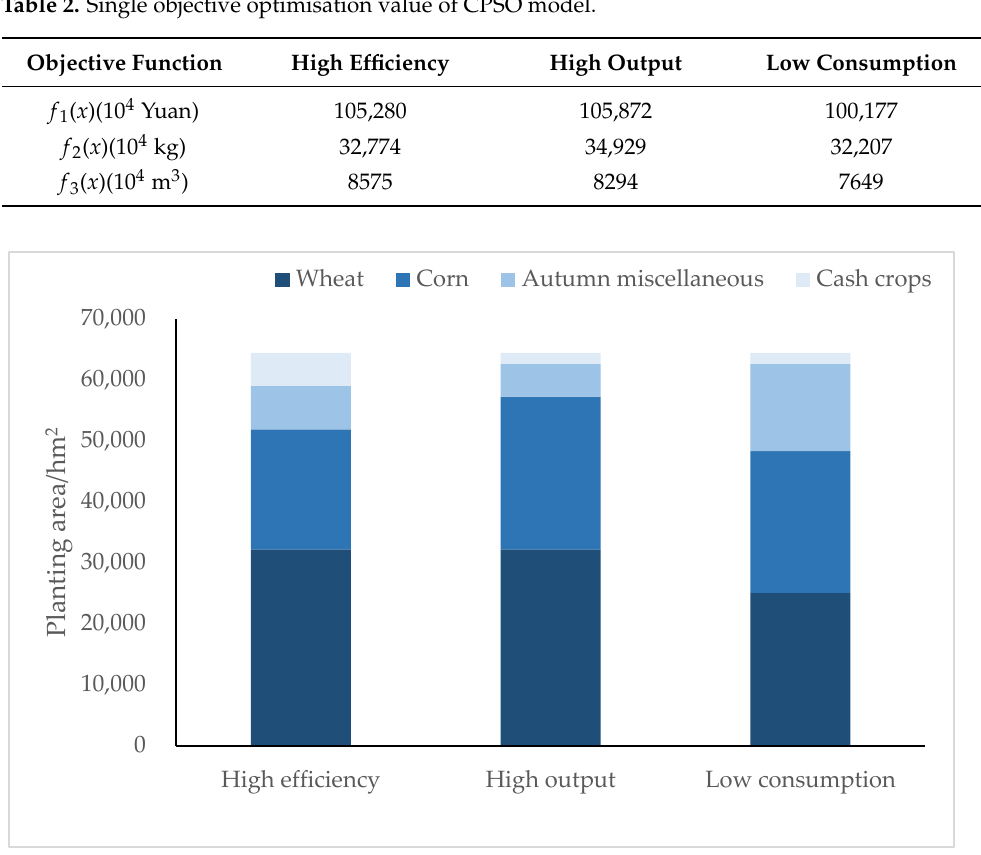
Figure 1. Individual optimal crop planting strategy according to each objective function.